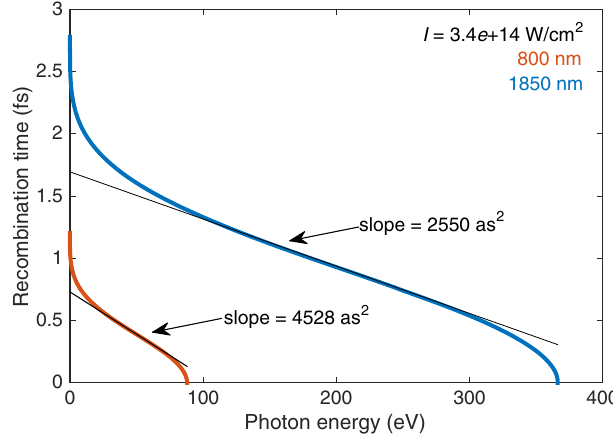
FIG. 2. Attochirp as a function of driving wavelength, 800 nm (red curve) and 1850 nm (blue curve).